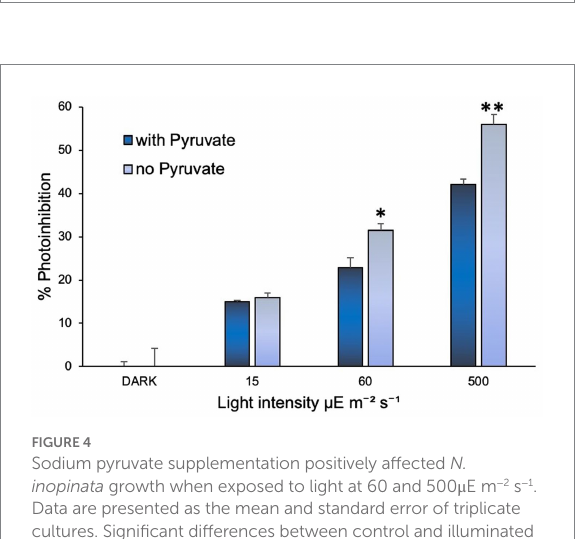
FIGURE 4 Sodium pyruvate supplementation positively affected N. inopinata growth when exposed to light at 60 and 500 μ E m − 2 s − 1 . Data are presented as the mean and standard error of triplicate cultures. Significant differences between control and illuminated cultures are represented as * p < 0.05 and ** p <